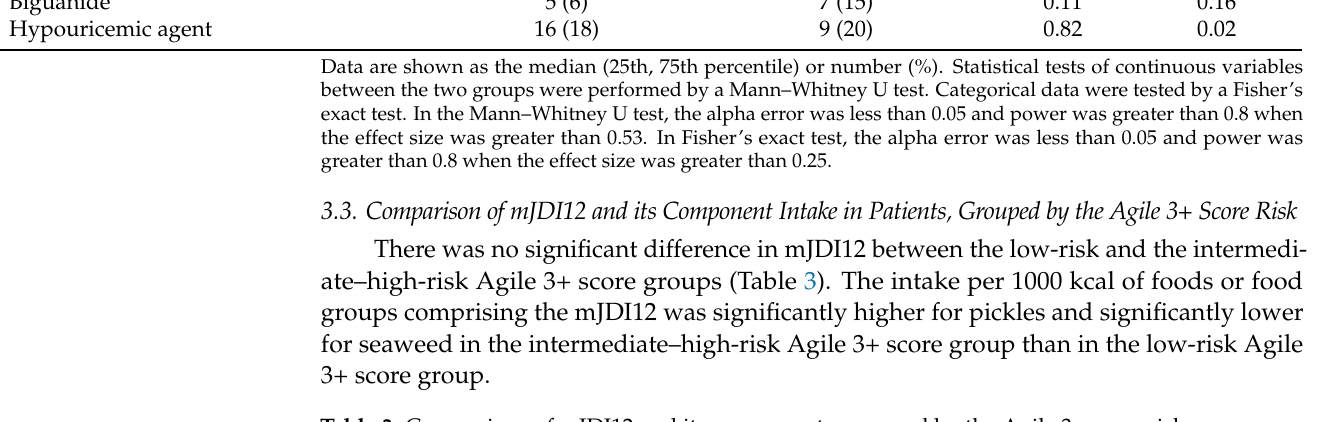
Table 3. Comparison of mJDI12 and its components, grouped by the Agile 3+ score risk. Low-Risk Agile